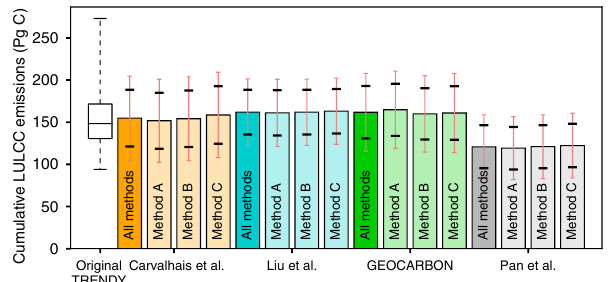
Figure 6. The global cumulative land-use and land-cover change (LULCC) emissions during 1901–2012 from original TRENDY models and from the estimates constrained by different biomass datasets with different methods to define deforestation grid cells. “All methods” represents the ensemble mean and uncertainty in the constrained results from Method A, Method B and Method C for each biomass dataset. The whisker–box plot represents the mini- mum and maximum values, 25th and 75th percentiles and the me- dian value of original TRENDY models. In the bar plot for the con- strained estimates, the red line represents the 1 σ Gaussian errors; the black ticks represent the 25th and 75th